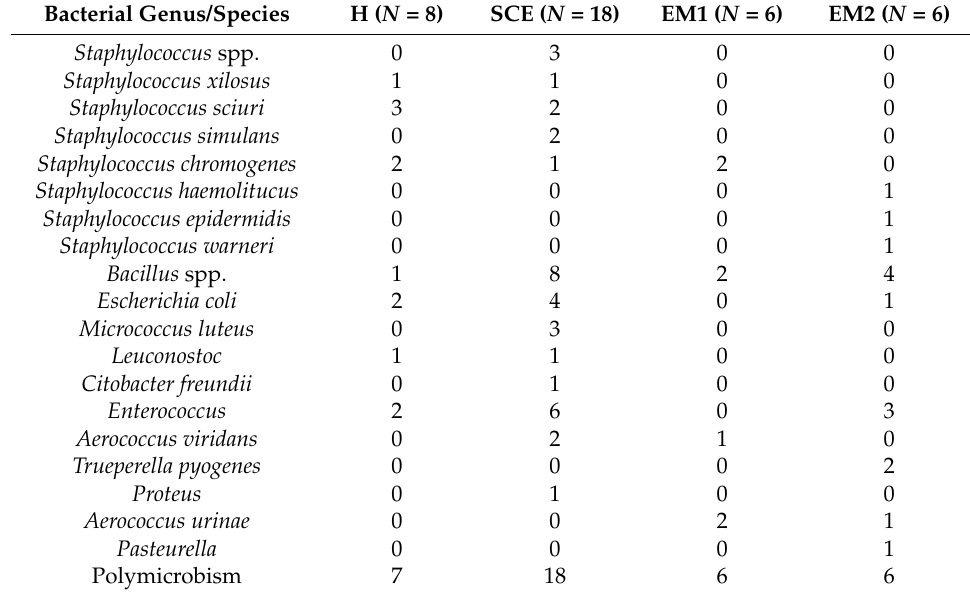
Table 2. Positive cows (N) in each diagnosis group to the bacterial genus/species isolated in microbiological cultivation from the uterine swabs of thirty-eight cows. Two or more bacterial genus/ species might be isolated and typed from the same